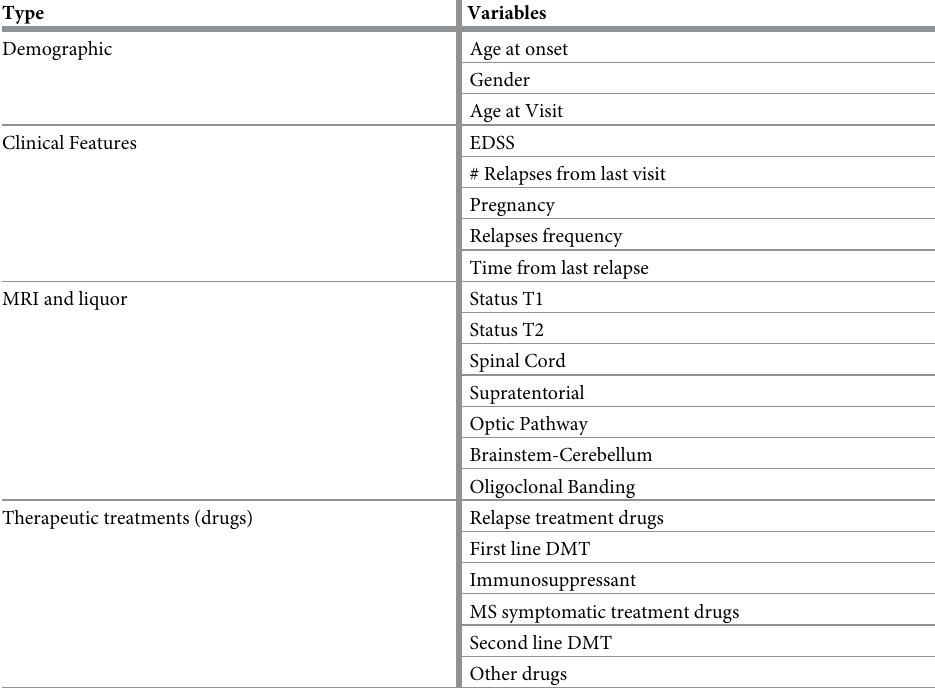
Table 2. Features used for training the machine learning models.